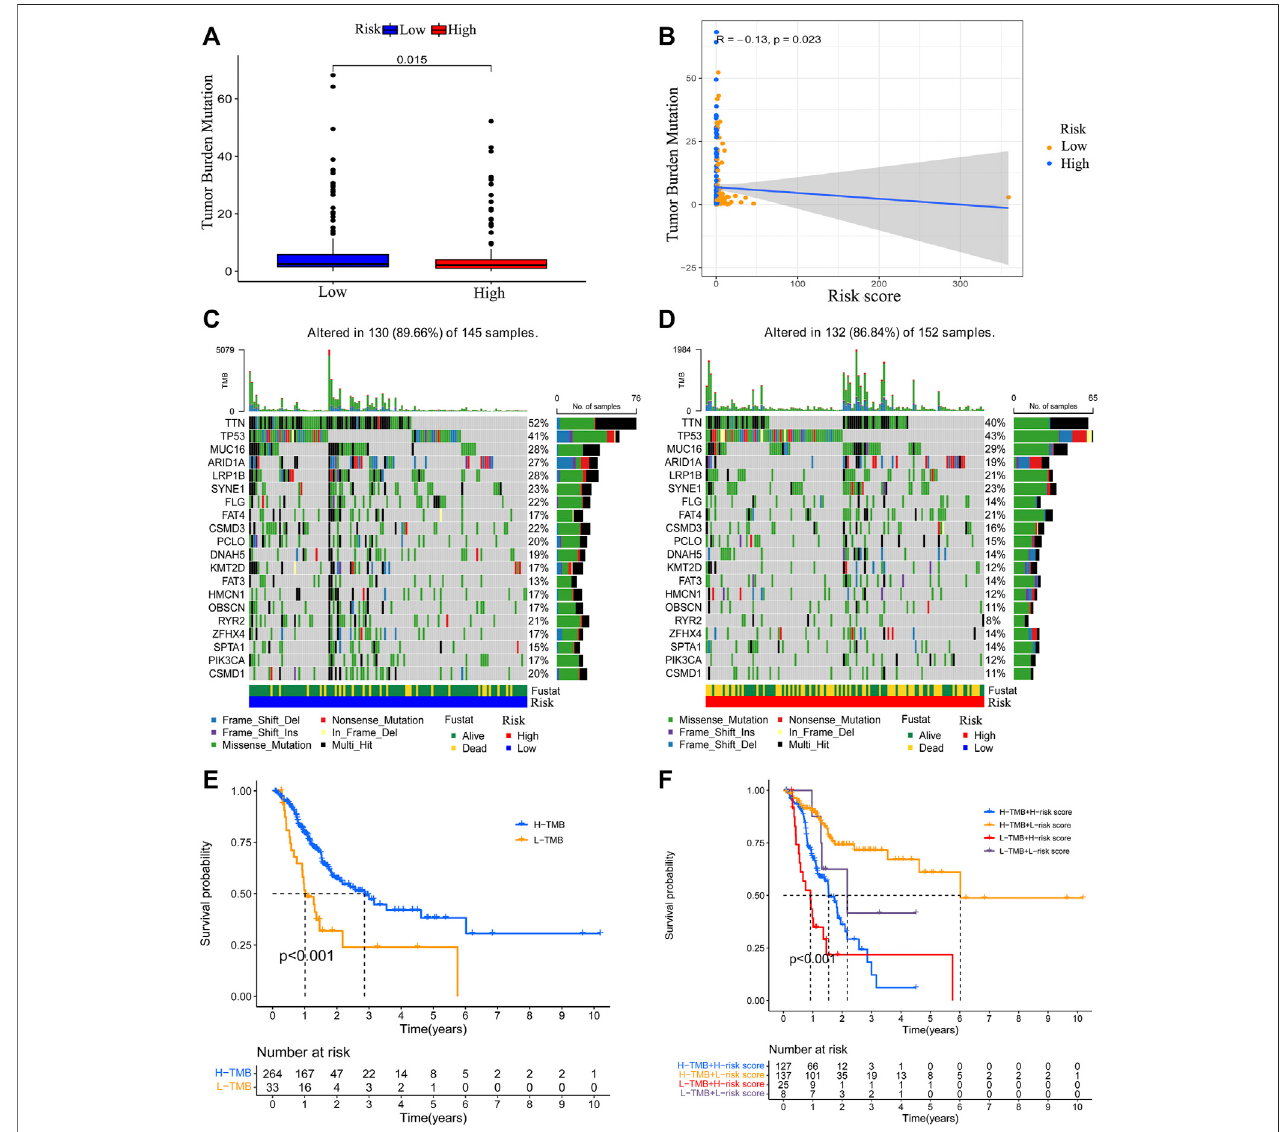
FIGURE9| CorrelationbetweentheriskmodelandTMBlevel.TherelationshipbetweenriskscorevalueandTMBlevel (A,B) .Thetop20genes ’ TMBstatuswere visualized in two groups (C, D) . The survival outcome of the patients with different TMB levels (E) . The survival outcome of patients with low or high TMB level and lower risk score value or higher risk score value (F)